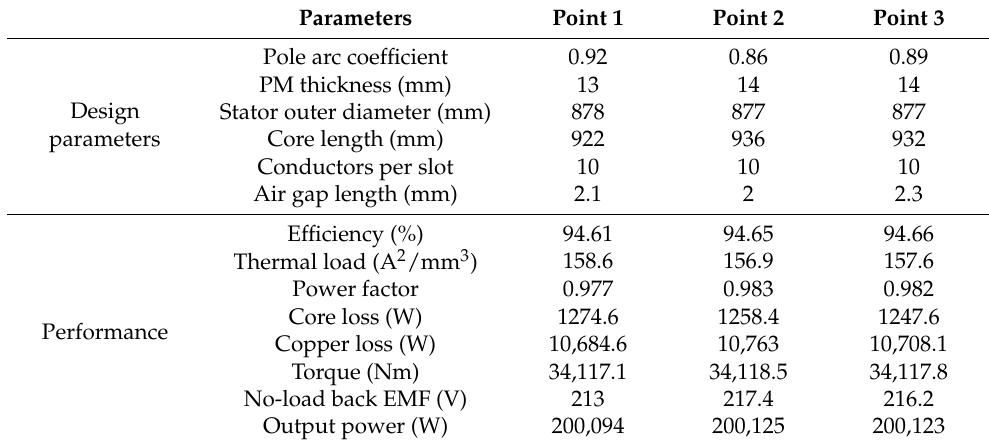
Table 3. Comparison of design parameters and performance parameters of three candidate points.